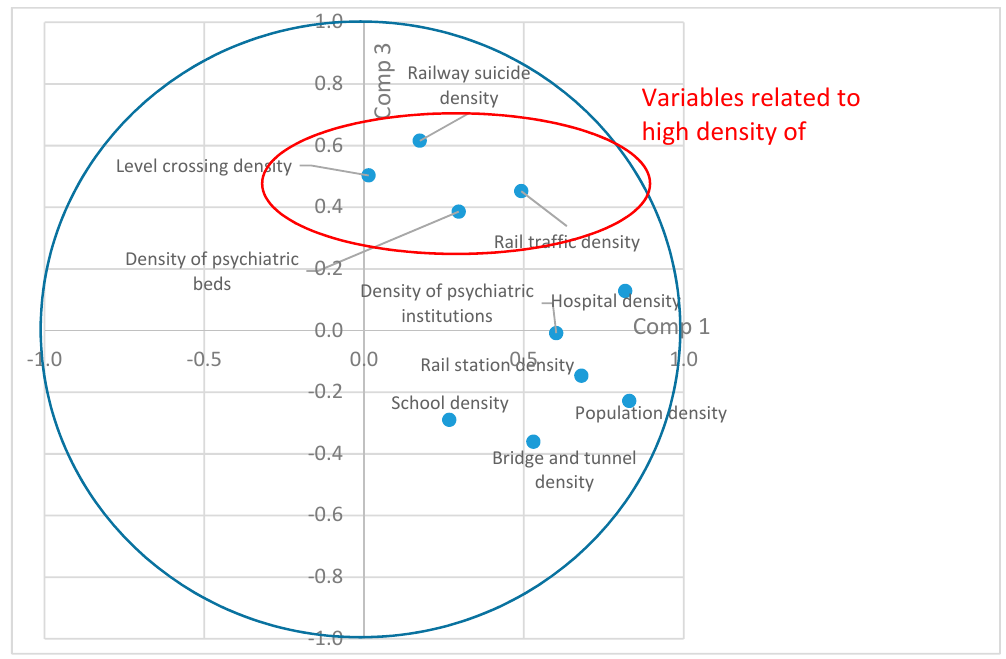
Figure 2. Saturation levels on Component Three.